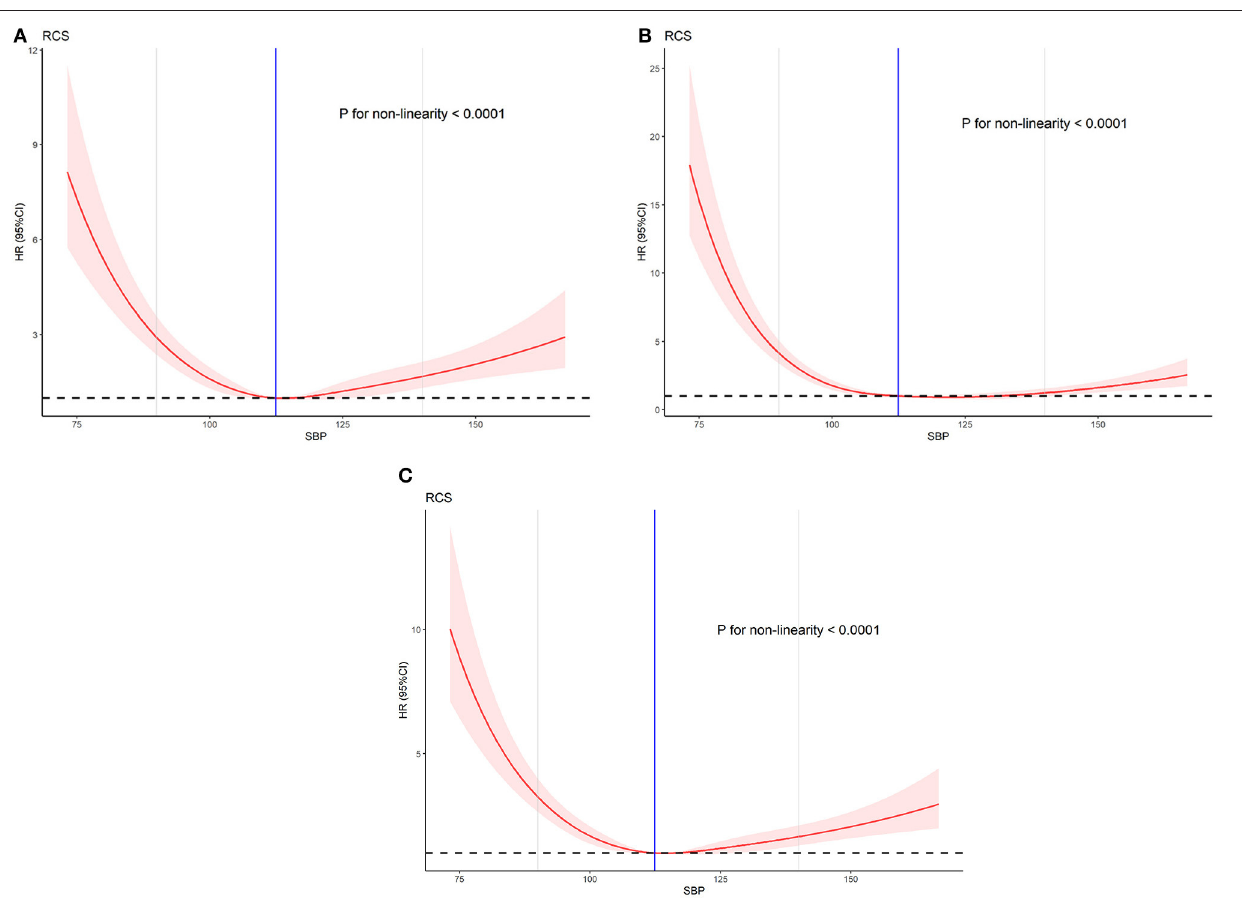
FIGURE 2 | The effect of different doses of SBP on the prognosis of AMI. (A) Univariate. (B) Adjusted for age, VF, VT, drug, SOFA, and APS-III. (C) Adjusted for age, VF, VT, Total_Ca, chloride, creatinine, phosphate, platelet, RDW, WBC, respiration rate, mean HR, mean glucose, drug, SOFA, and APS-III.